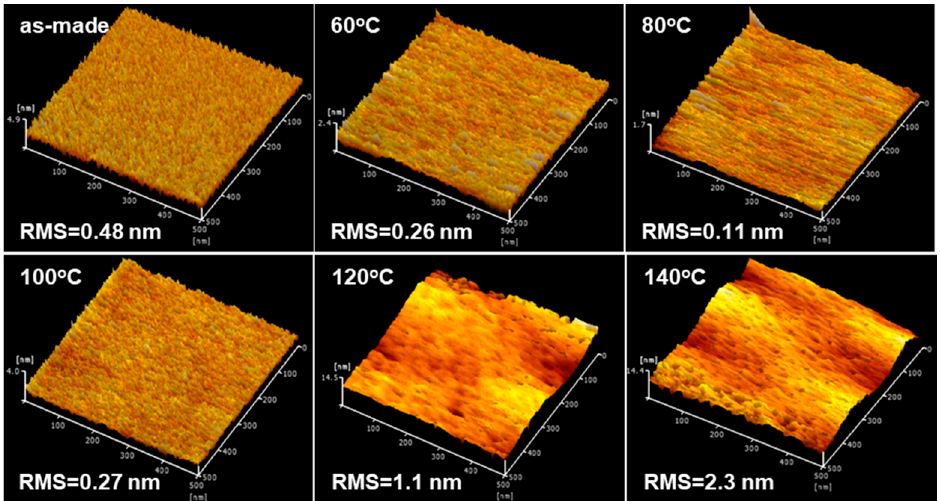
Figure 3. The AFM images of the PbS ink films annealed at different temperatures. Root-mean-square (RMS) surface roughness values of the pristine PbS ink film and the films annealed at 60, 80, 100, 120, and, 140 °C are 0.26, 0.11, 0.27, 1.1, and 2.3 nm, respectively.